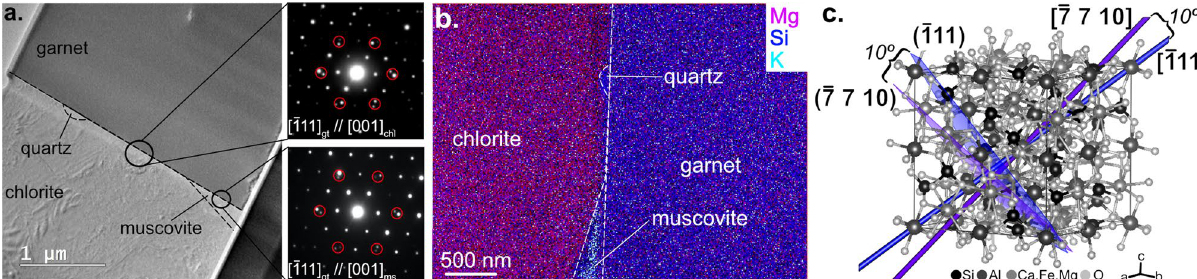
Figure 2. TEM results. ( a ) Transmission Electron Microscopy (TEM) image of mineral interface. Diffraction patterns of the garnet-chlorite interface (top) and garnet-muscovite interface (bottom) oriented such that [ ] gt is parallel to [0 0 1] chl,ms . The doubling of planes (highlighted by red circles) suggests an epitaxial relationship between garnet and chlorite and between garnet and muscovite. ( b ) Stacked electron dispersive spectrometry maps of Mg (magenta), Si (blue), and K (light blue) abundances showing the 4 phases in the TEM foil. Sample is rotated relative to ( a ). ( c ) Garnet crystal structure (from Novak and Gibbs 28 ) highlighting the [ − 7 7 10 ] [ gt crystal directions (blue and purple lines, respectively) and (